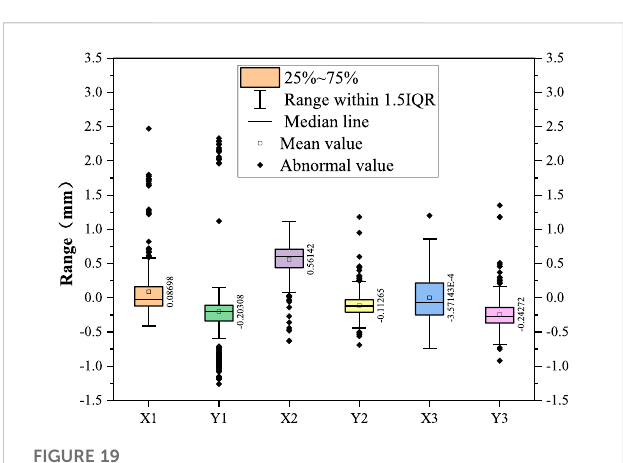
FIGURE 19 Analysis of box line analysis of joint difference deformation monitoring at different measuring points from 16 April 2022 to 20 May 2022.